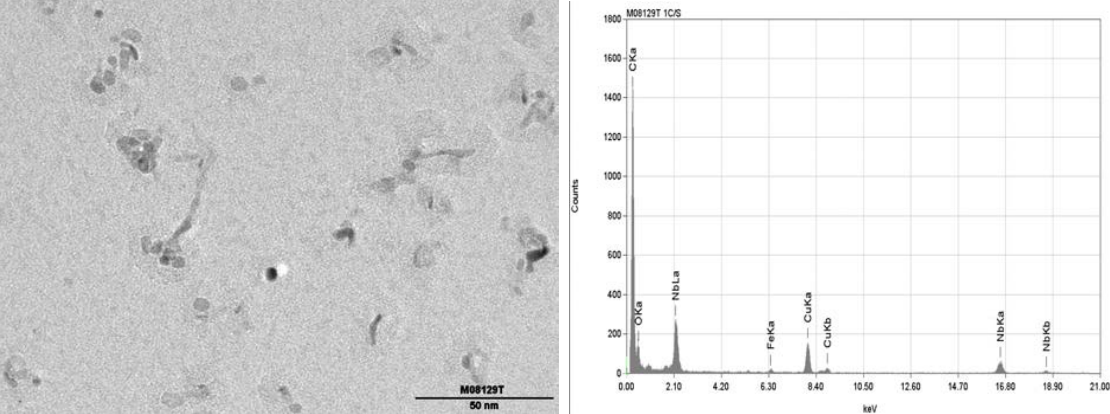
Figure 14. Bright field TEM image of fine Nb-rich particles in the 0.08% Nb sample cooled at 1 °C/s with the corresponding EDS